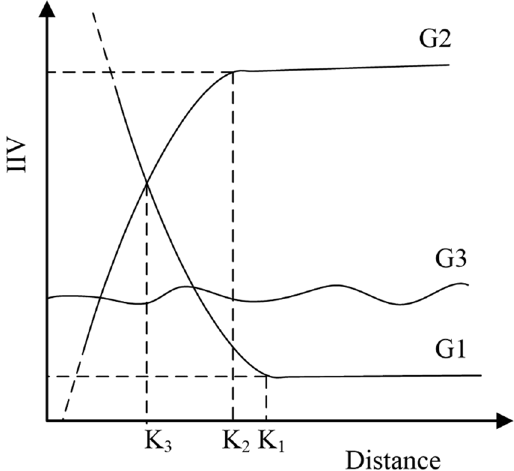
Figure 5. Theoretical paradigm for assessing the effect of pipeline project construction on changes in the structure of the surrounding plant community. Distance represents the distance from the pipeline construction. G1 represents the plant species with low or non-existent presence in the original ecological communities, but became dominant plants after being affected by the construction and incidental factors. G2 represents the plant species with dominant positions in the original ecological communities but whose IIV decreased in the area of pipeline construction. G3 represents the remaining plants not classified as G2 or